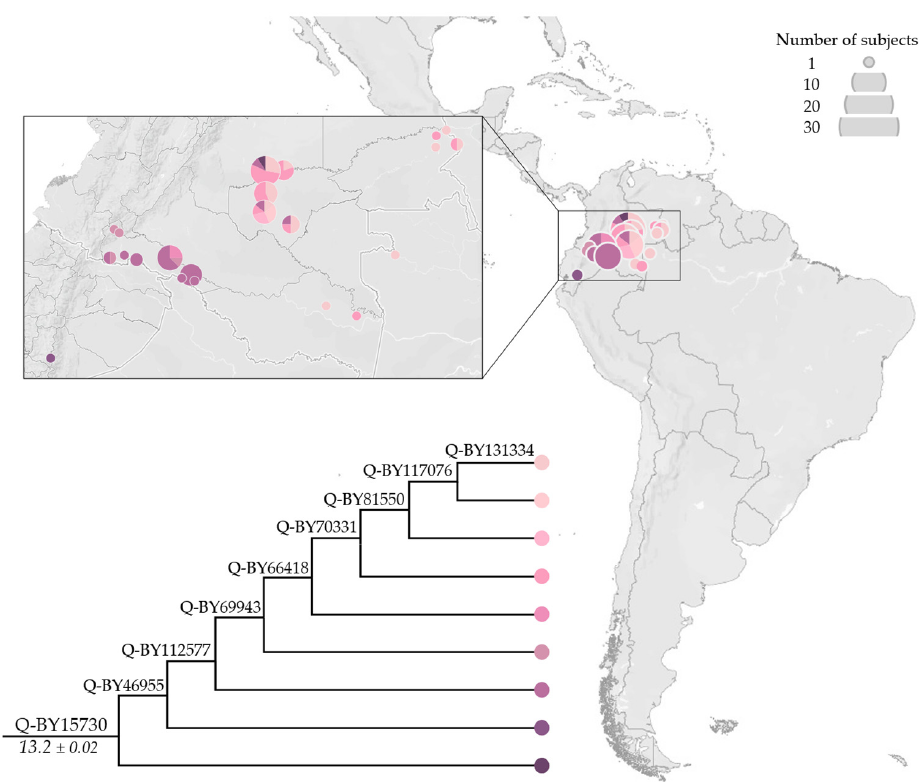
Figure 7. Geographical distribution of Q-BY15730 (not reported in ISOGG, http://www.isogg.org/tree/, accessed on 19 January 2022) and its main sub-lineages. In the phylogeny, the estimated age of the node (±StDev) is reported in kya.